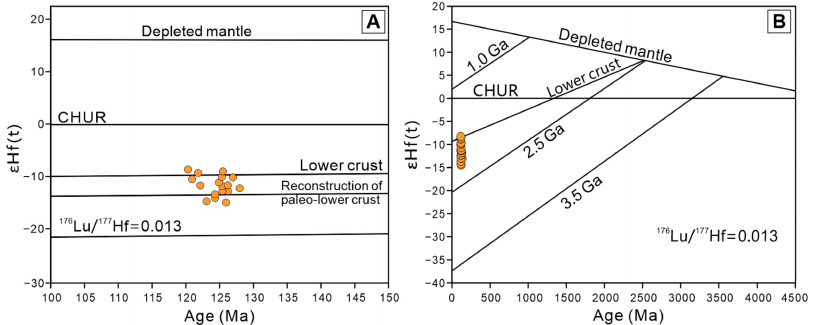
Figure 10. ( A , B ) are ε Hf(t) vs. age (Ma) diagrams for lamprophyre (20CS15) from the Weishan area. ( A ) is enlarged from ( B ) to show the data